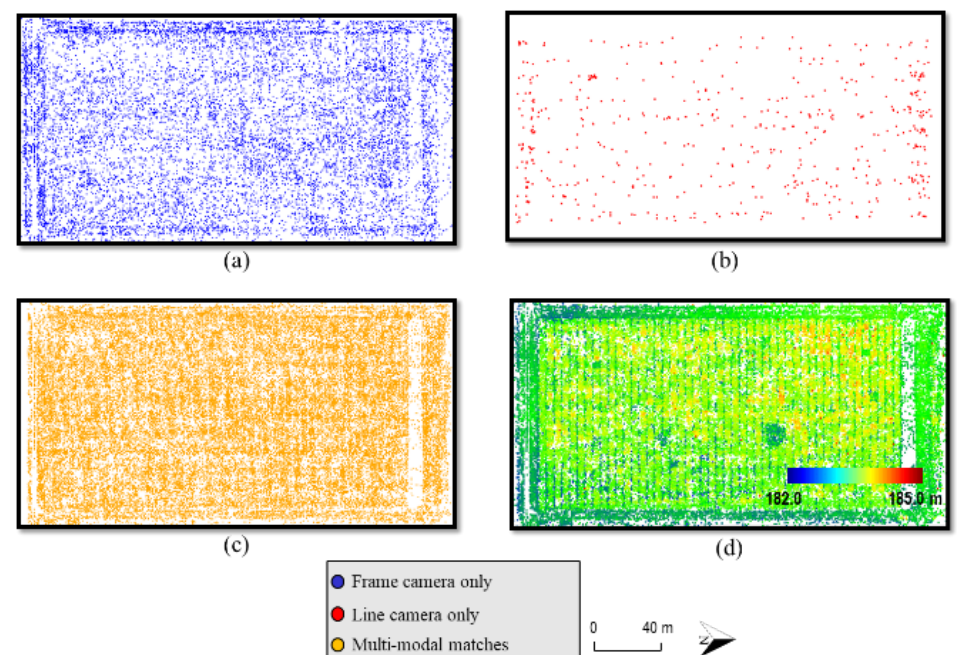
Figure 5. Top view of the 3D reconstruction results for the Agriculture dataset: (a) ~16,000 points identified in frame camera imagery only, (b) ~500 points identified in line camera scenes only, (c) ~49,000 points identified in frame and line camera imagery, and (d) all ~65,500 reconstructed points colored by height.